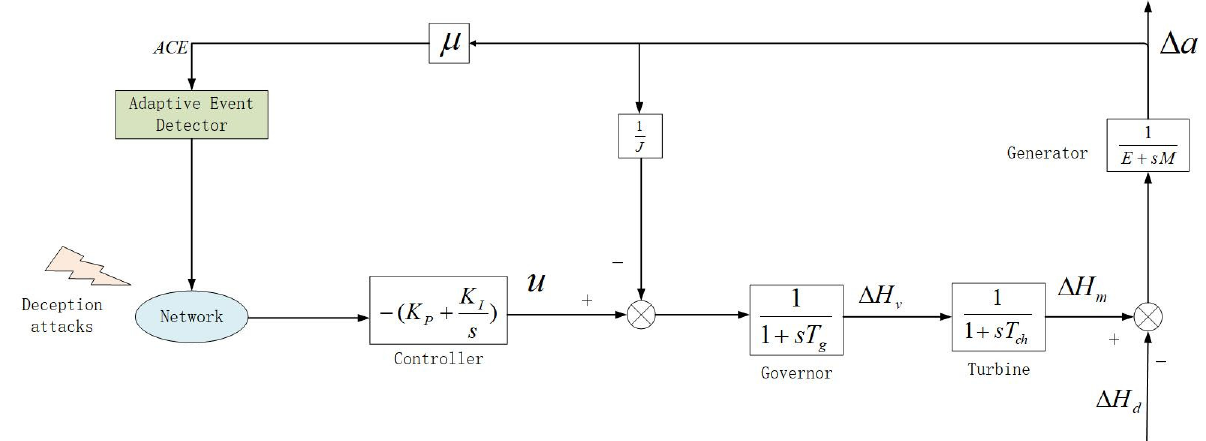
Figure 1. Structure of the LFC system with adaptive